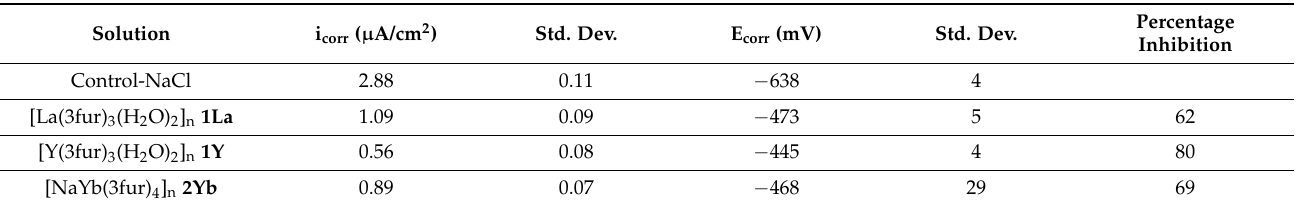
Table 3. Summary of corrosion parameters obtained from potentiodynamic polarisation tests in control and inhibited solutions after 24 h immersion.